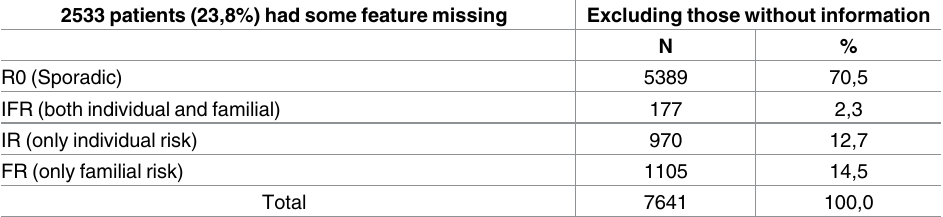
Table 2. Hereditary risk